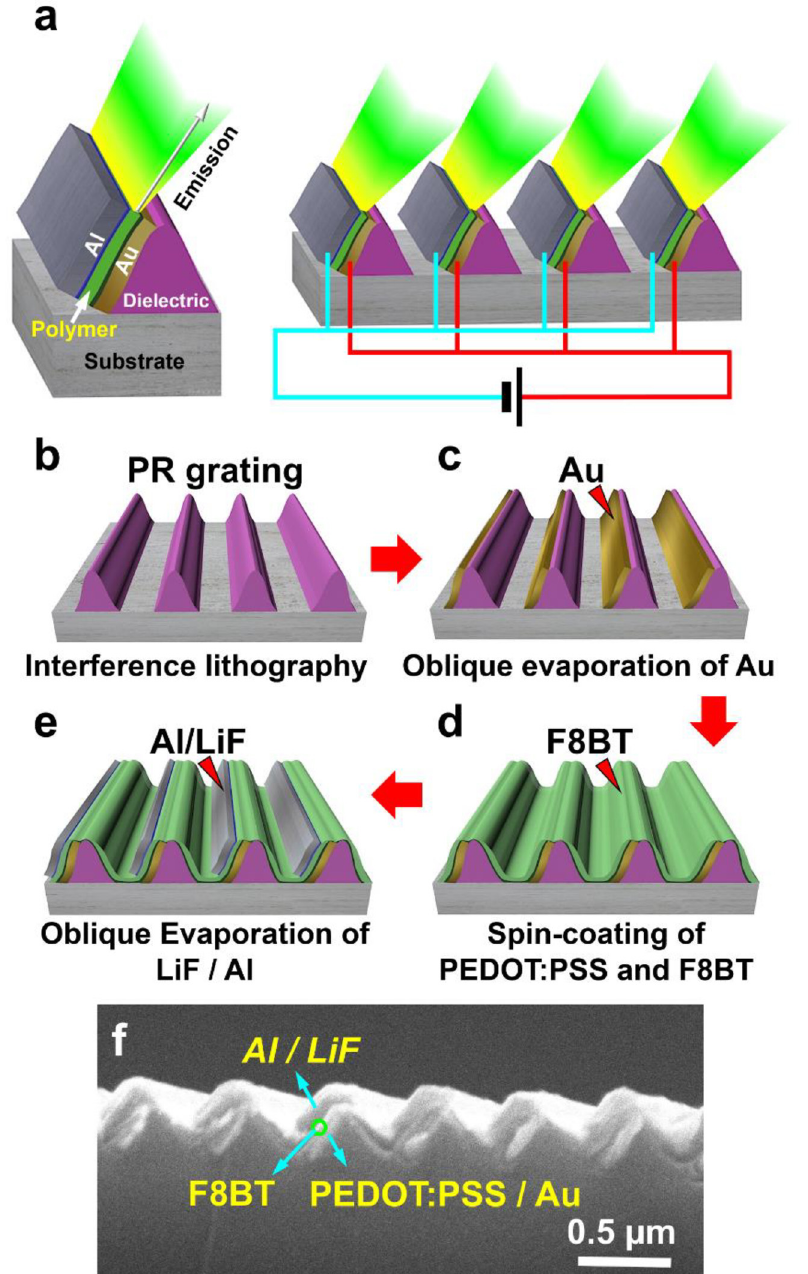
Figure 1: (a) Schematic illustration of the design of the periodic array of the end- emitting nano OLEDs with directional output. (b) – (e) Fabrication procedures: (b) Interference lithography of a PR-grating template; (c) Oblique evaporation of the Au nanostrips as electrodes on the side walls of the grating lines; (d) Spin-coating of a hole-transport layer of PEDOT:PSS and the activelayerofF8BT;(e)Obliqueevaporation of theelectron-transportlayerof LiFandthe cathodeof Al strips. (f) Cross-sectional SEM images of the end-emitting nano